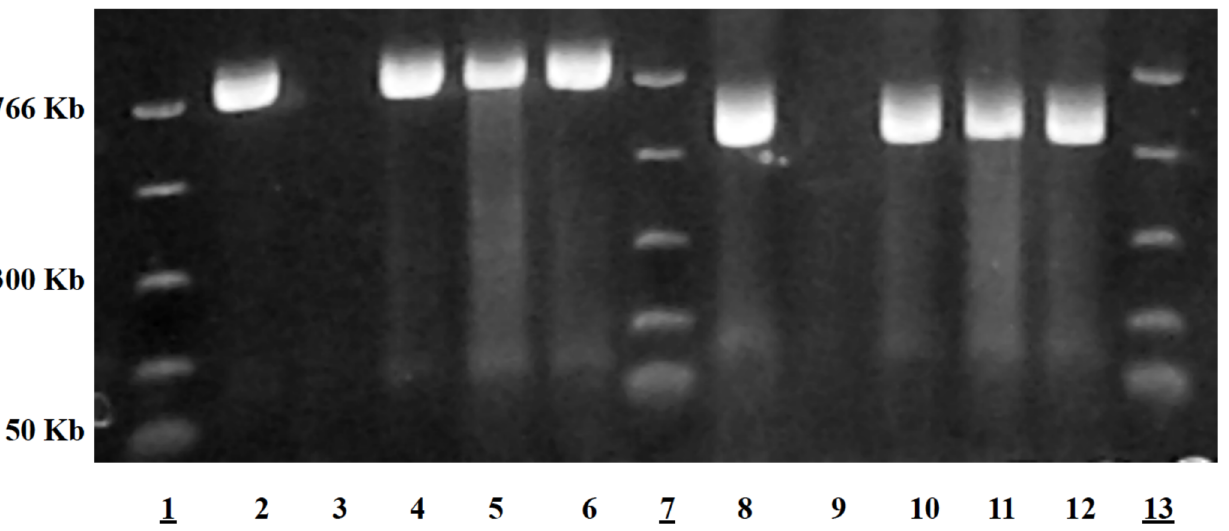
Fig 3. O153 wzx and wzy genes amplified by PCR using primers from sequences presented in this investigation. Lanes 1, 7, 13: Molecular weight markers. Lane 2: Positive control for O153 targeting wzx gene, Lane 3: Negative control, Lanes 4,5,6: wzx amplified for three clinical isolates. Lane 9: Positive control for O153 targeting wzy gene. Lane 10: Negative control, Lane 11,12,13: wzy amplified for three clinical isolates.